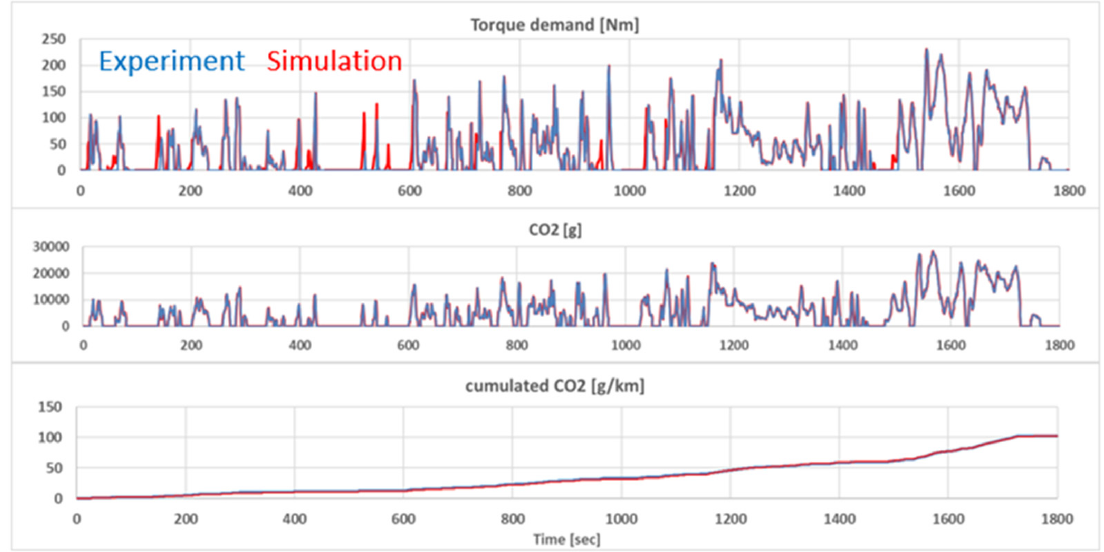
Figure 7. Simulation validation for torque and CO 2 on a C-segment vehicle test without hybridization (cold WLTC).